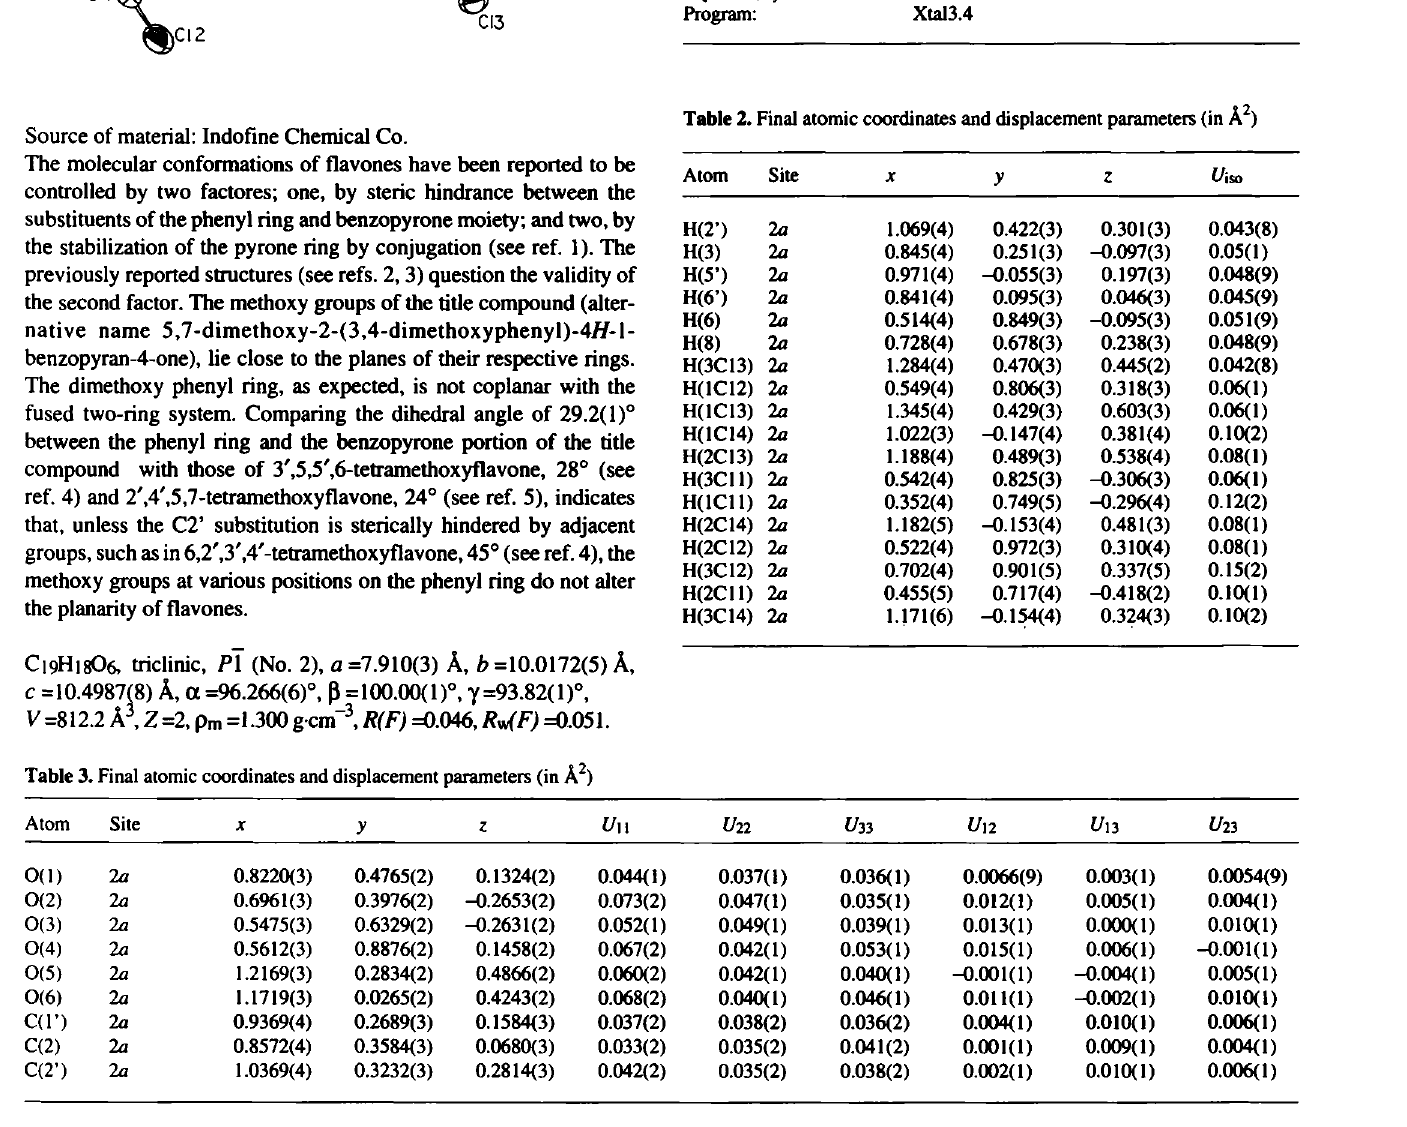
Table 3. Final atomic coordinates and displacement parameters (in Â 2 )